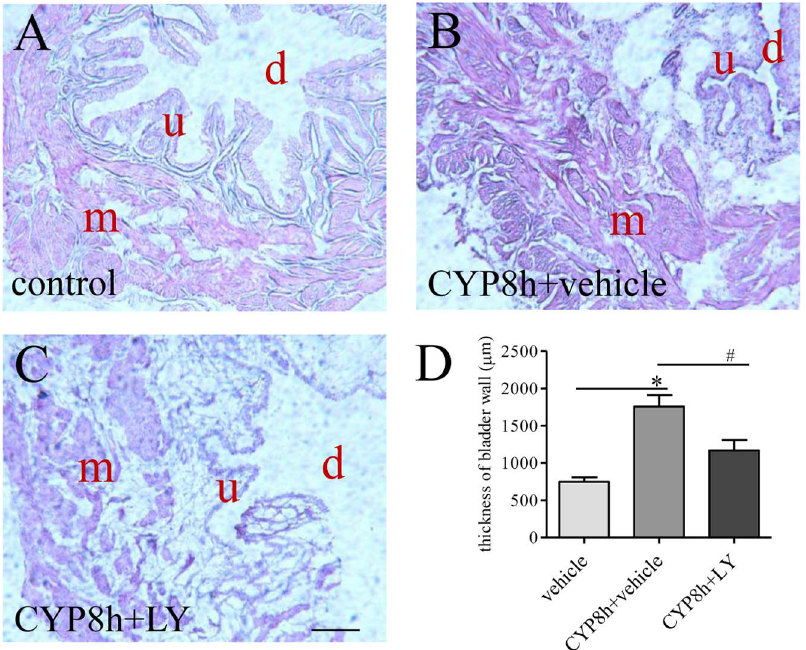
Fig. 3. Postmortem examination by H&E showed PI3K inhibition on bladder wall thickening during cystitis. Transverse sections (10 m m) of the urinary bladder from control (A), cystitis (B) and cystitis with LY294002 (LY) treatment (C) were stained by H&E (m: muscular layer; u: urothelium; d: bladder dome). The thickness of the bladder wall was increased by cystitis (D). LY294002 treatment reduced bladder wall thickness caused by cystitis (D). Bar 5 200 m m. n 5 3. *, p , 0.05 vs vehicle control. # , p , 0.05 vs CYP